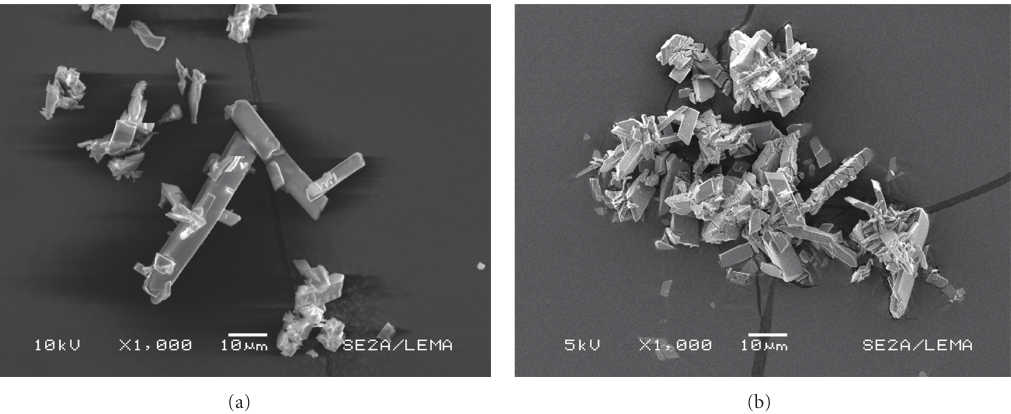
Figure 3: Neodynium III oxalate crystals obtained in the free vortex (a) and in the forced vortex (b).